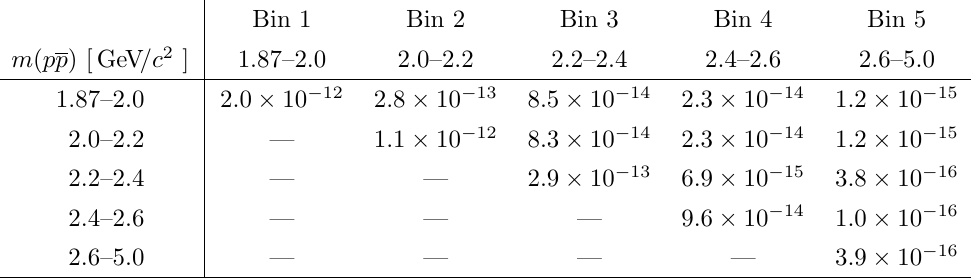
Table 5 . Covariance matrix for bins of m ( pp